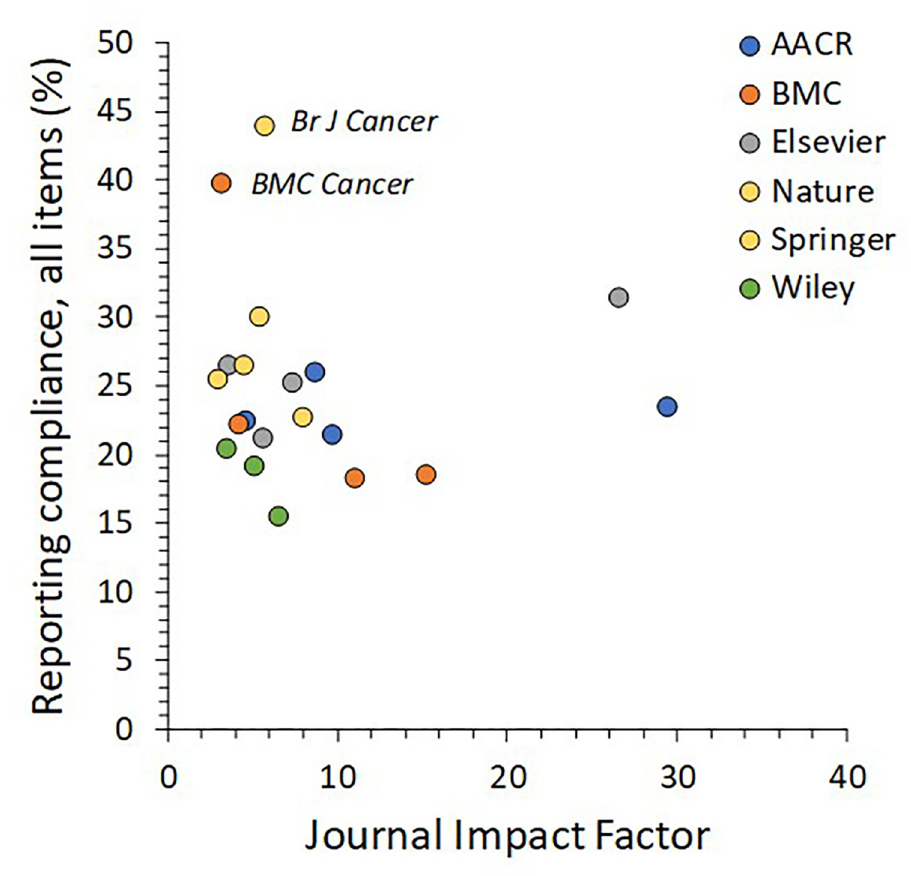
Fig 2. Association of journal impact factors and percent overall animal care & welfare reporting for mouse-based oncology studies in 20 journals.